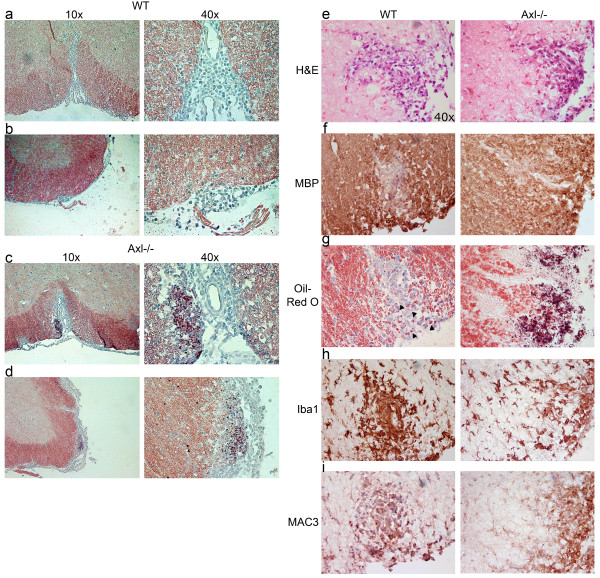
Axl-/- mice do not clear myelin debris as efficiently as WT mice. Ten micron frozen WT and Axl-/- spinal cord sections were stained with the lipid dye Oil-Red-O (a,b,c,d,g). Myelin debris appears as dense red clumps. Arrowheads in g show sparse Oil-Red-O+ deposits in the WT lesion. Representative 10× (a,b,c,d left panel) and corresponding 40× (a,b,c,d right panel) images are shown for the ventral (a,c) and lateral (b,d) funiculi of WT (a,b) and Axl-/- mice (c,d, e,f,g,h,i) 40× images of sections showing H+E (e), MBP (f), Iba1 (h) and MAC3 (i) for WT and Axl-/- mice.